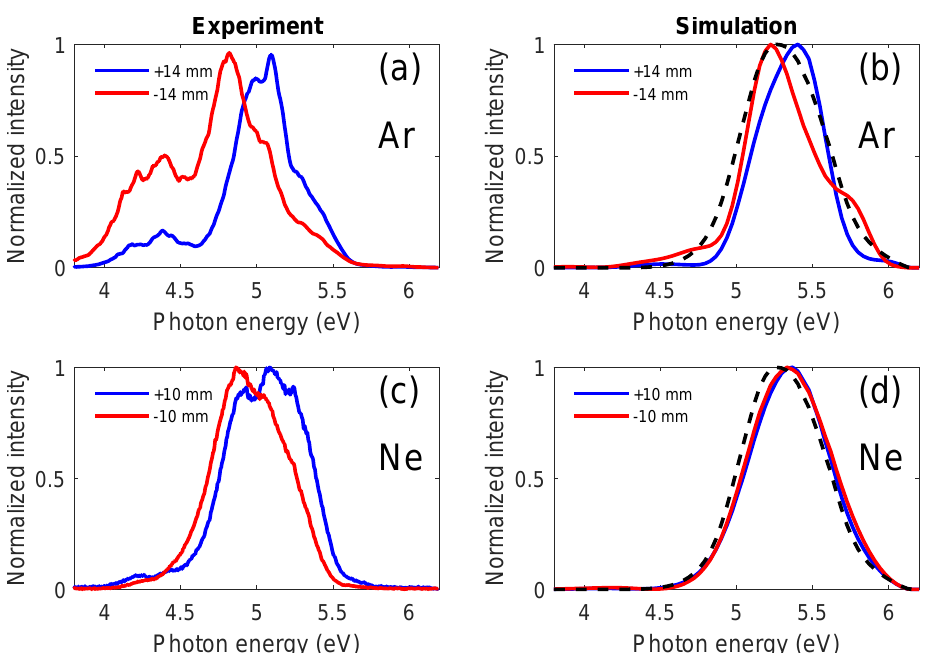
Figure 5. ( a , c ) The experimental spectra taken at the dashed lines in Figure 3c,d, respectively. ( b , d ) DUV spectra obtained from simulation performed using the experimentally observed laser parameters. More details on the simulation results are discussed in Figure 6. Dashed lines in ( b , d ) show an analytic solution of the third-harmonic spectrum obtained by Fourier transforming the cube of the fundamental laser E ( t ) in the temporal